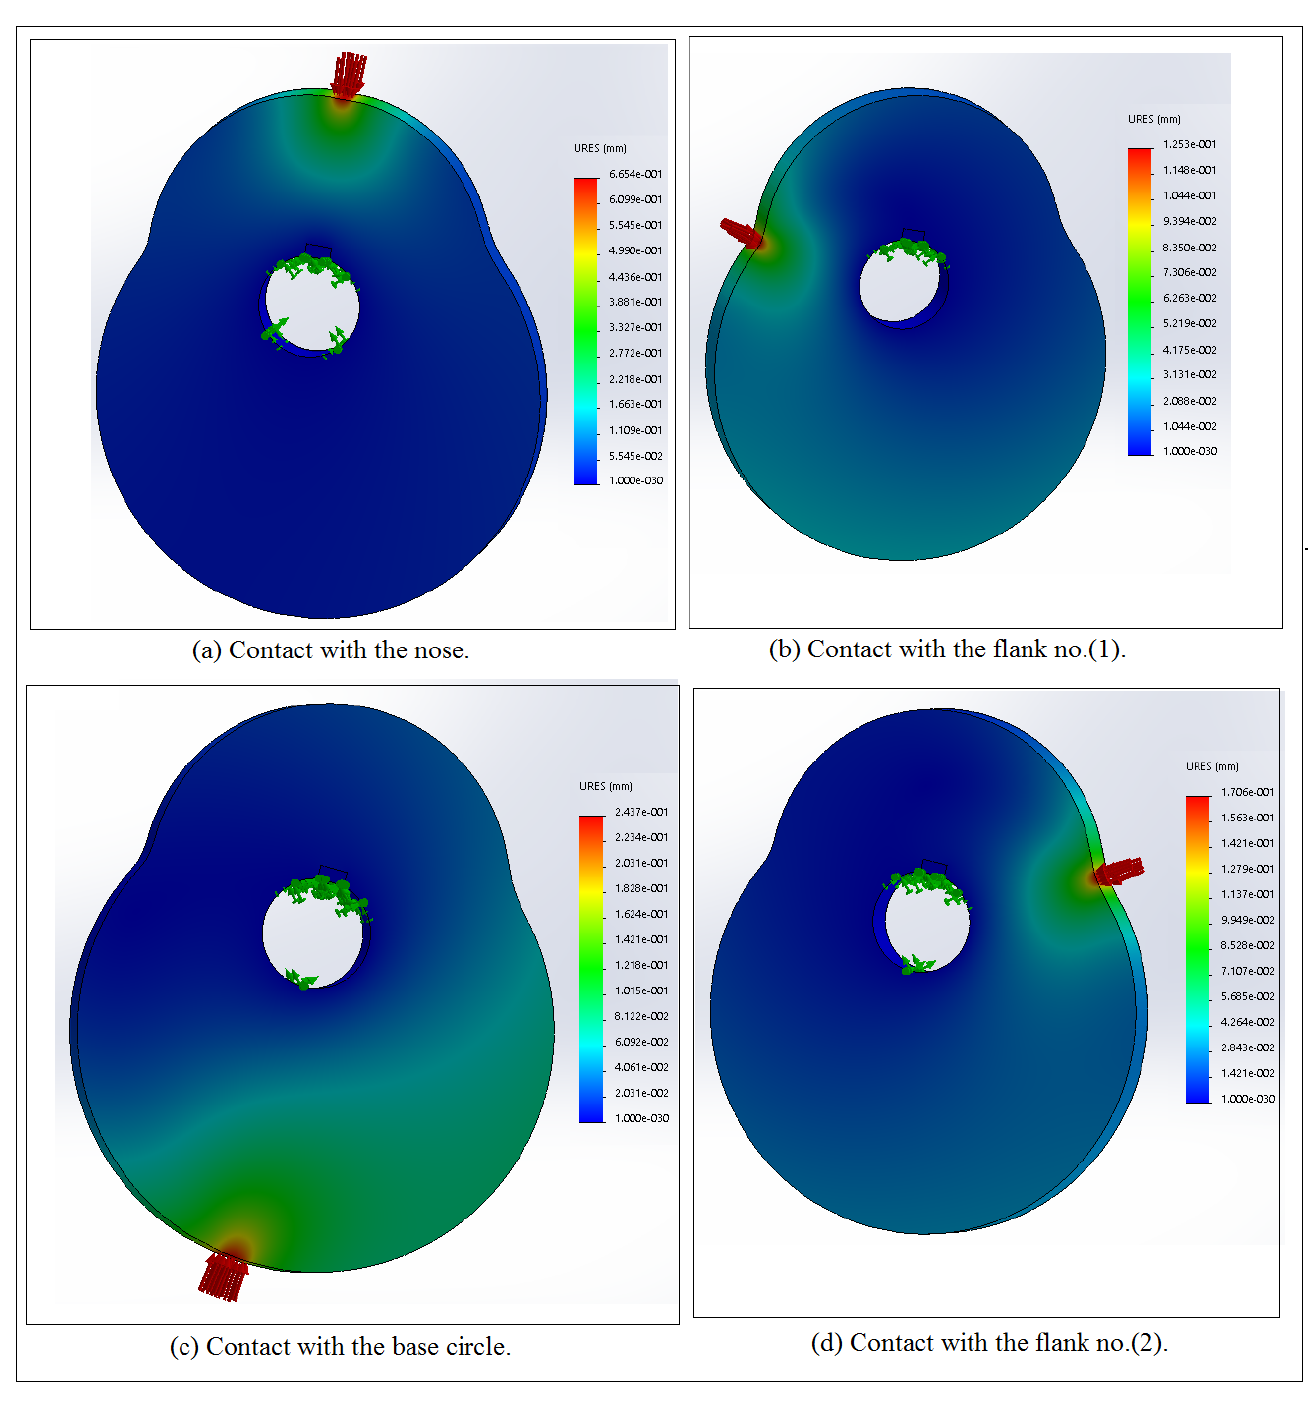
Figure 22. Bending deflection mapping contour for profile no.(3) at different contact locations.